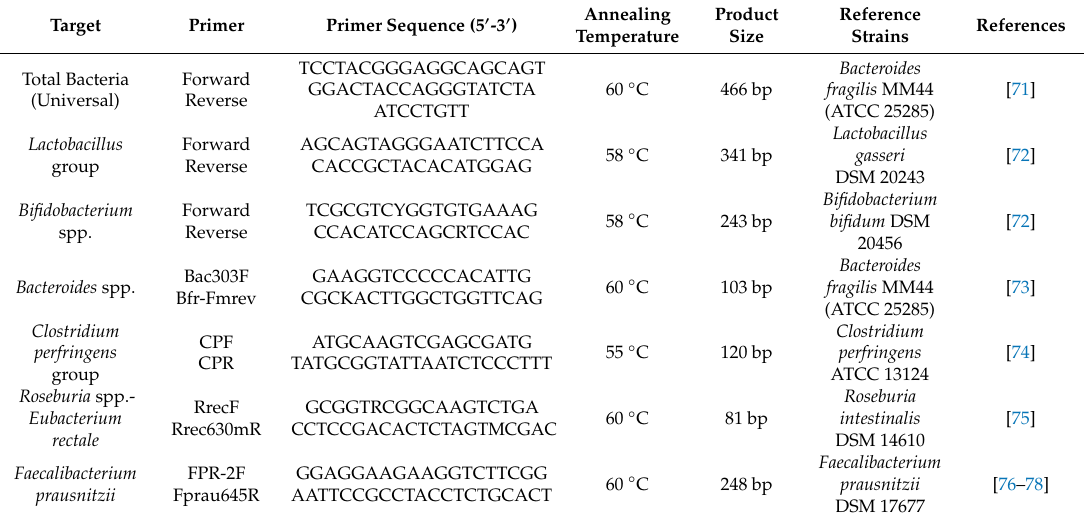
Table 6. Primers and qPCR characteristics of gut microbiota analysis (adapted by Mitsou, et al. [64]). Target Primer Primer Sequence (5 (cid:48) -3 (cid:48)